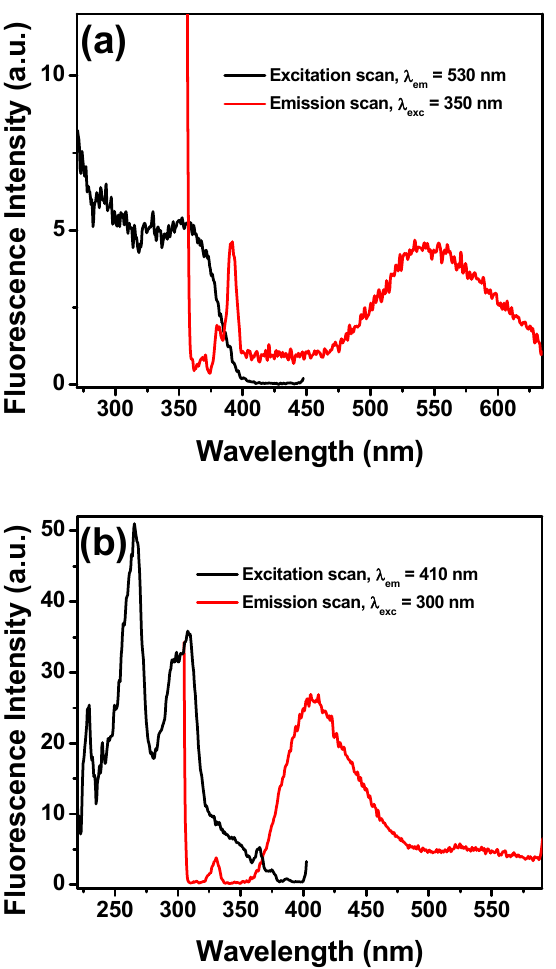
Figure 11. Emission (red) and fluorescence excitation (black) spectra of NpTP (~1 × 10 − 6 M) in acetonitrile for ( a ) λ exc is 350 nm to obtain emission spectrum and λ em is monitored at 530 nm for excitation scan; ( b ) λ exc is 300 nm to obtain emission spectrum and λ em is monitored at 410 nm for excitation scan.